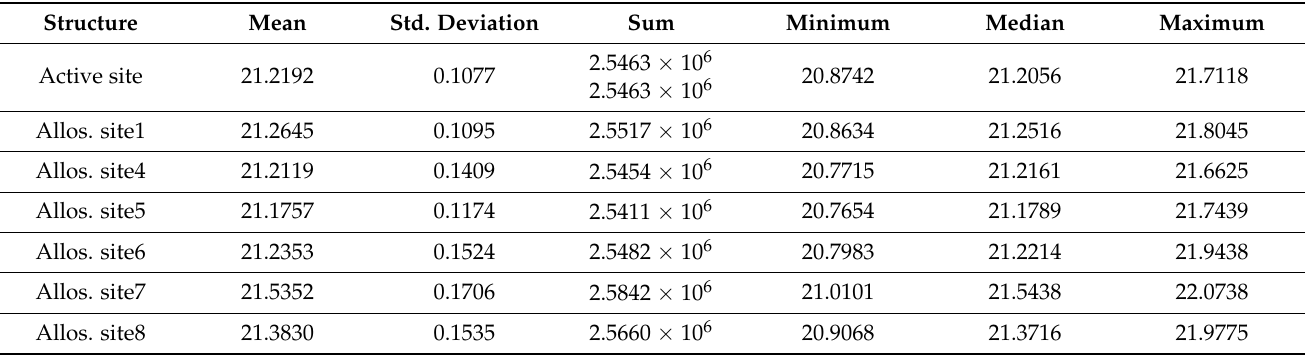
Table 5. Data analysis of the RoG (in Å) scores over the simulation time (120 ns). Std. represents standard, and Allos. site indicates allosteric site.